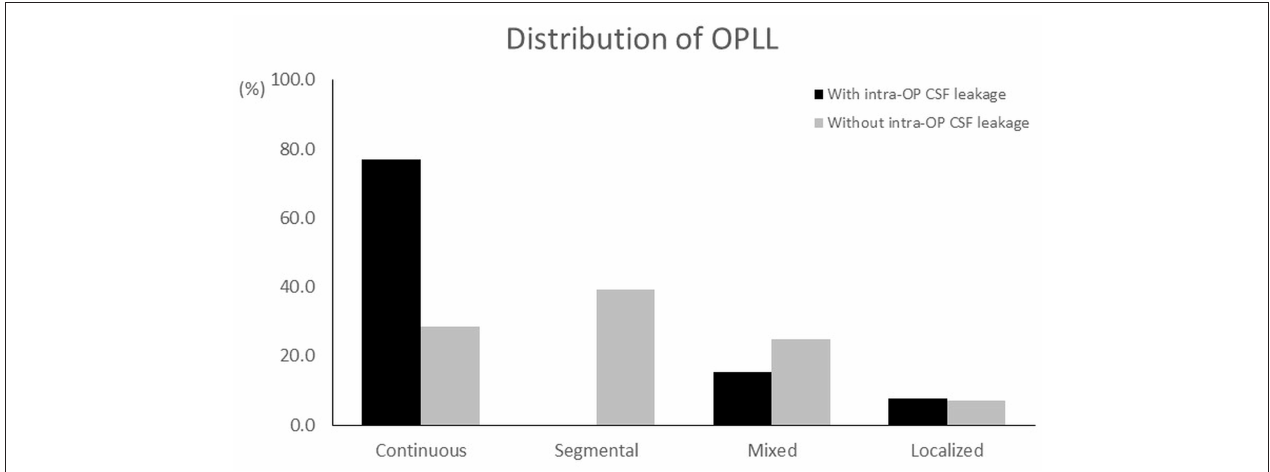
FIGURE 2 | Comparison of type of OPLL between the groups with and without intra-operative CSF leakage. In the group with intra-operative CSF leakage, the continuous type of OPLL had the highest percentage (77%), followed by the mixed type (15%), localized (8%), and segmental (0%). For the group without intra-operative CSF leakage, the segmental type of OPLL had a higher percentage (39%) than the others; the percentages of the continuous, mixed, and localized types were: 29, 25, and 7%, respectively.